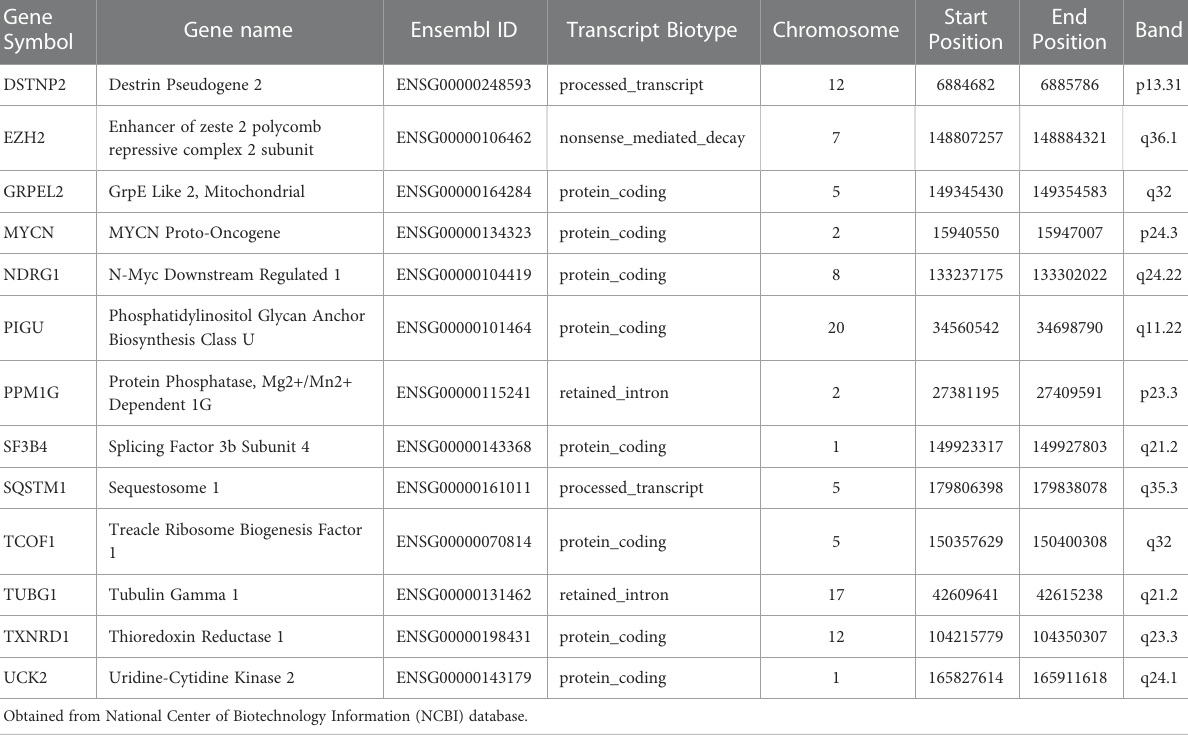
TABLE 1 Details of the Hub genes.